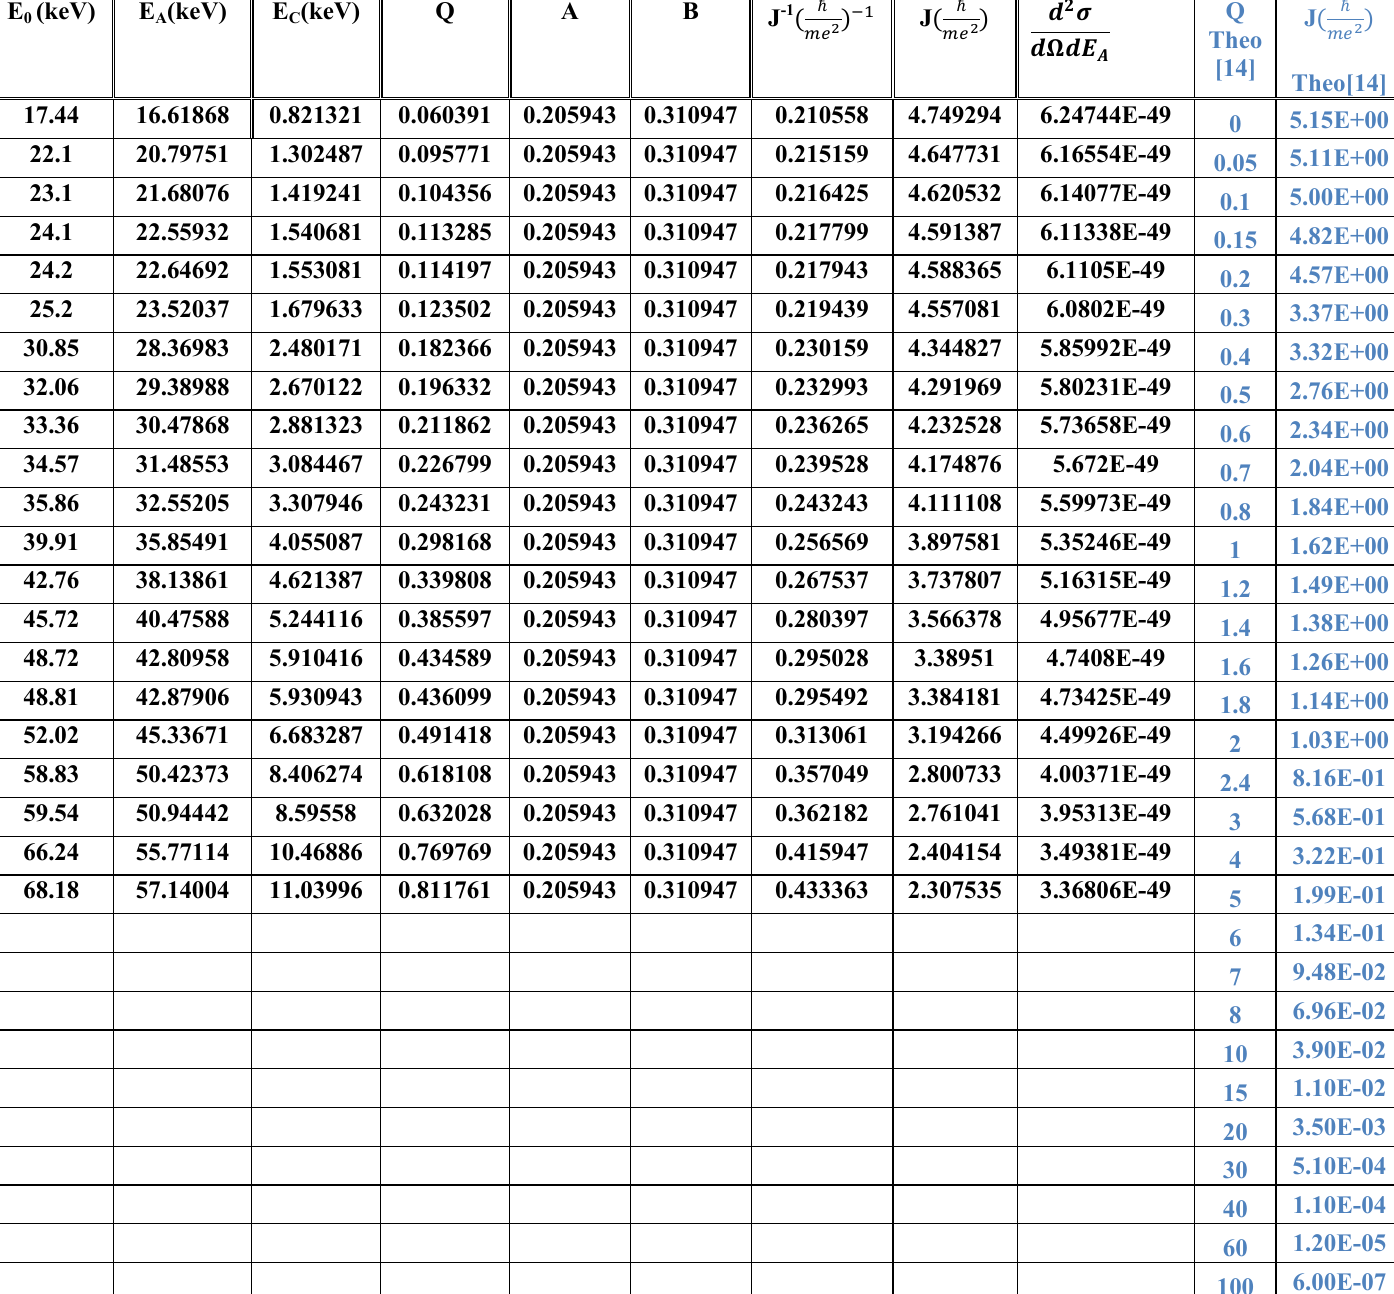
Table 4: The double-differential scattering cross section of Doppler broadening at angle (cid:2786)(cid:2777) ° for